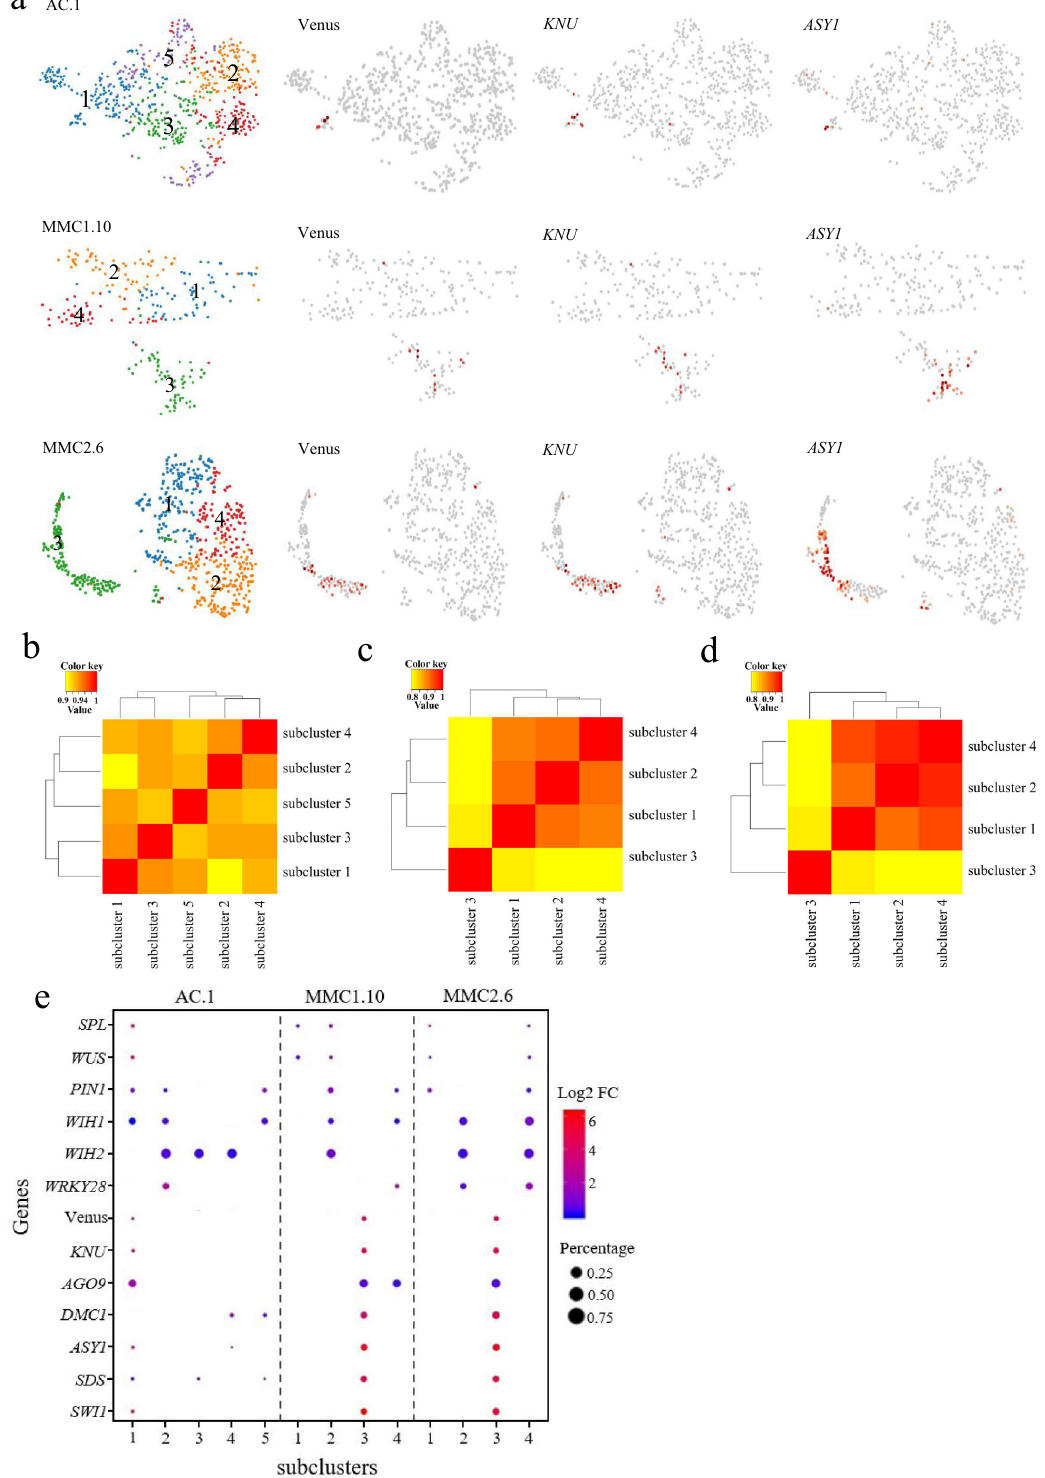
Fig. 3 Identi fi cation of subclustering of the female germline-associated cell clusters. a t-SNE visualizations of cells from the AC.1, MMC1.10, and MMC2.6 clusters. Left, fi ve, four, and four subclusters (denoted by colors and numbers) were identi fi ed from the three clusters, respectively. Right, expression pro fi les of selected MMC marker genes in each sample. b – d Pearson correlation coef fi cient analyses of the subcluster correlation in the AC.1 ( b ), MMC1.10 ( c ), and MMC2.6 ( d ) cell clusters. The value is Pearson correlation coef fi cient. The yellow-to-red color bar represents the Pearson correlation coef fi cient from low to high. e Expression of marker genes in the subclusters of the AC.1, MMC1.10, and MMC2.6 cell clusters. Dot size represents the proportion of cells in each cluster expressing a given gene. Color represents the relative expression level (Log2 FC) of the given